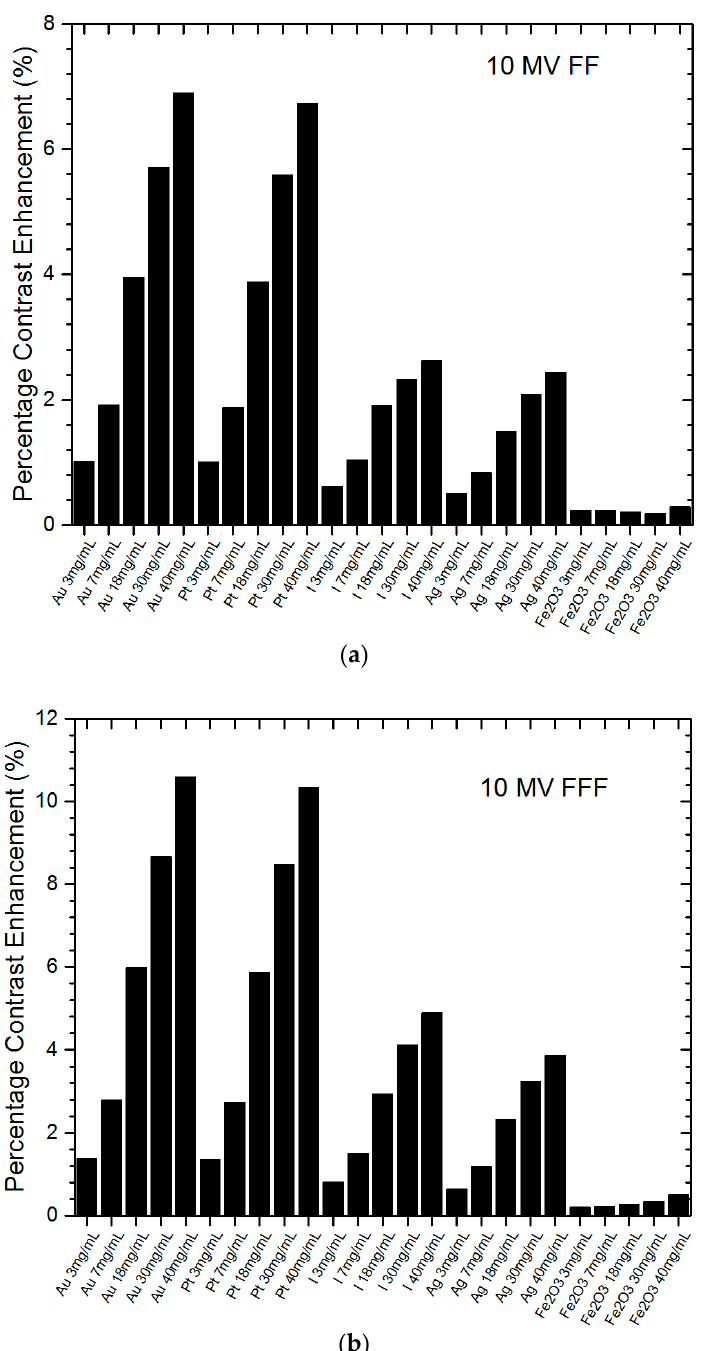
Figure 2. Relationships of percentage contrast enhancement for portal imaging with nanoparticle material and concentration using the 10 MV ( a ) FF and ( b ) FFF photon beams. Gold (Au), platinum (Pt), iodine (I), silver (Ag) and iron oxide (Fe 2 O 3 ) NP with concentrations equal to 3, 7, 18, 30 and 40 mg/mL were used. The percentage contrast enhancement was calculated as the percentage of increase of imaging contrast ratio when NP were added to the tumour.